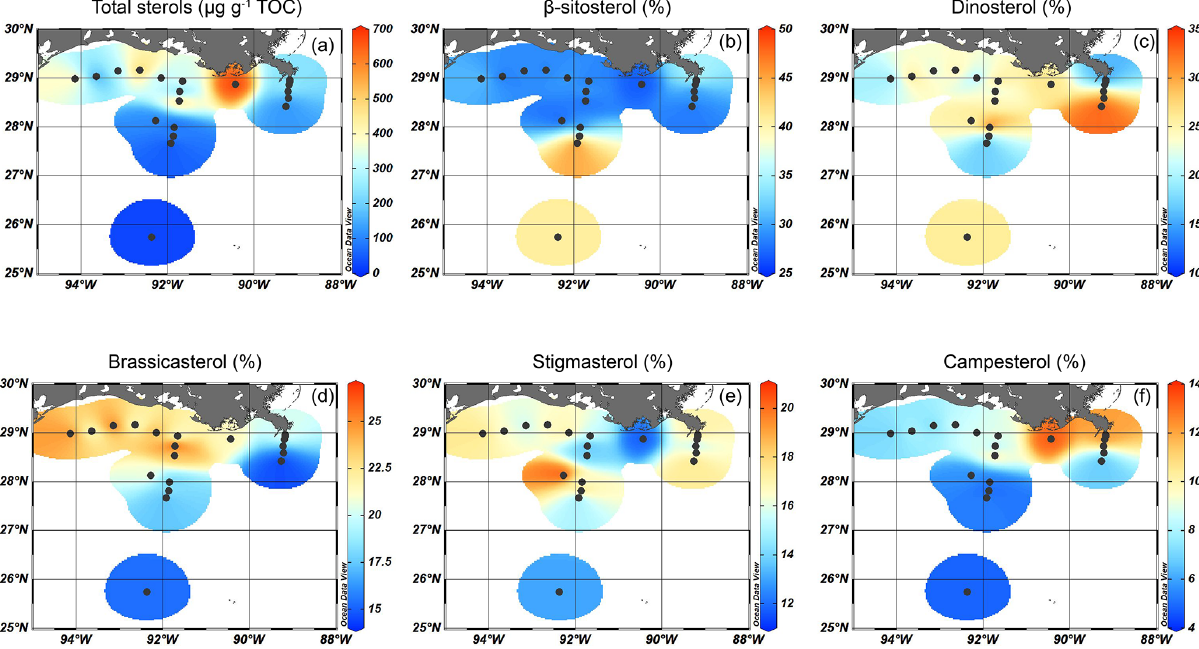
Figure 6. Isosurface plots showing (a) the total sterol concentration and (b–f) relative abundances of the individual sterols; (b) β -sitosterol, (c) dinosterol, (d) brassicasterol, (e) stigmasterol, and (f)